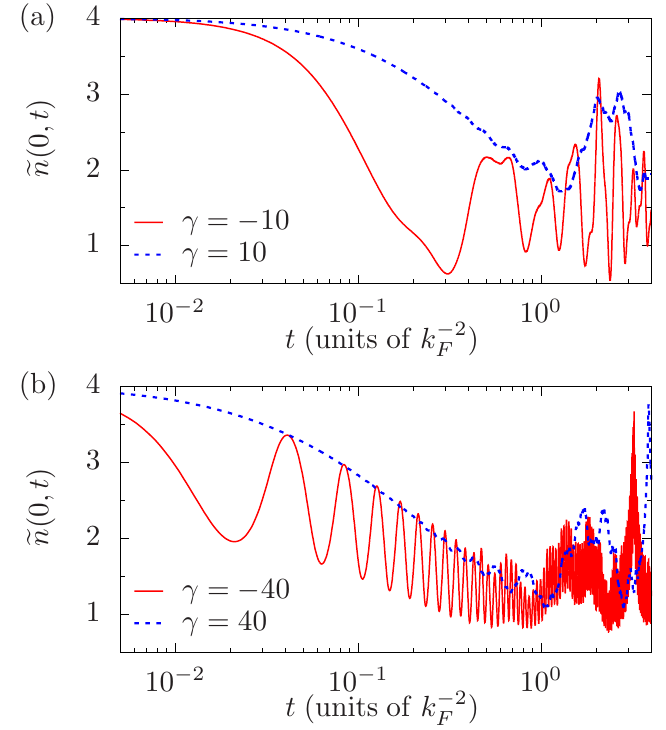
n ( 0, t ) for N = 4 particles (cid:101)